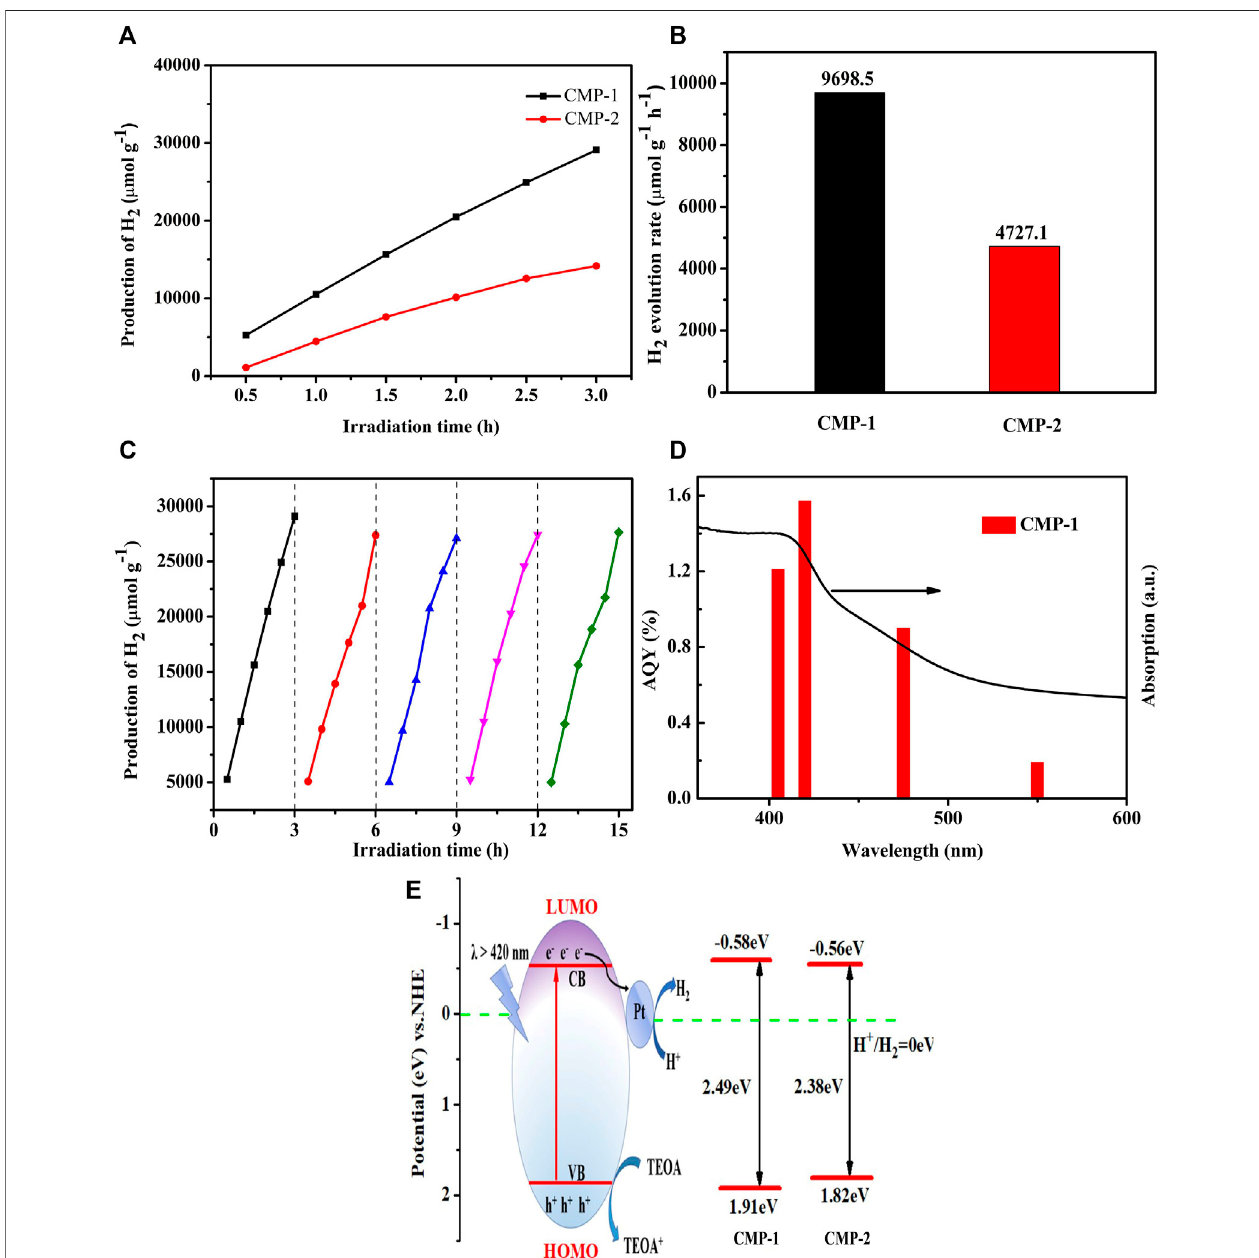
FIGURE 7 | (A) The time-dependent hydrogen production of the CMP materials; (B) comparison of photocatalytic H 2 evolution activity of CMP-1 and CMP-2; (C) the photocatalytic experiment with CMP-1 over fi ve periods, 3 h for each period; (D) wavelength dependent AQY values ofCMP-1,and a300-W Xenon-lamp equipped with series of band-pass fi lters (405, 420, 455, and 550 nm) is used as light source; (E) energy diagram and photocatalytic hydrogen evolution mechanism.